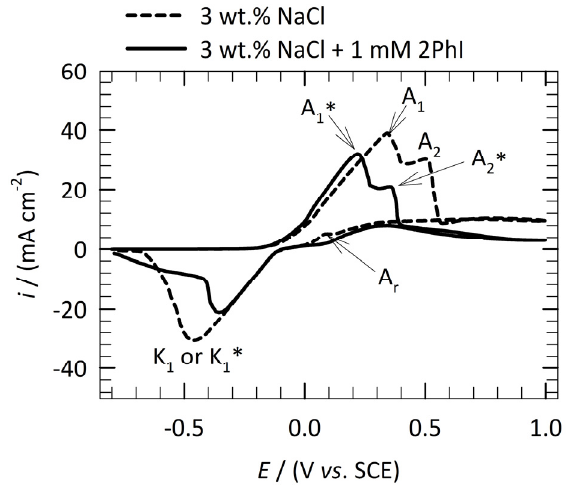
Figure 3. Cyclic voltammograms of the copper samples after 1 h of immersion in noninhibited [5] and 2PhI ‐ inhibited 3 wt.% NaCl solution, obtained with a potential sweep rate of 20 mV s − 1 .